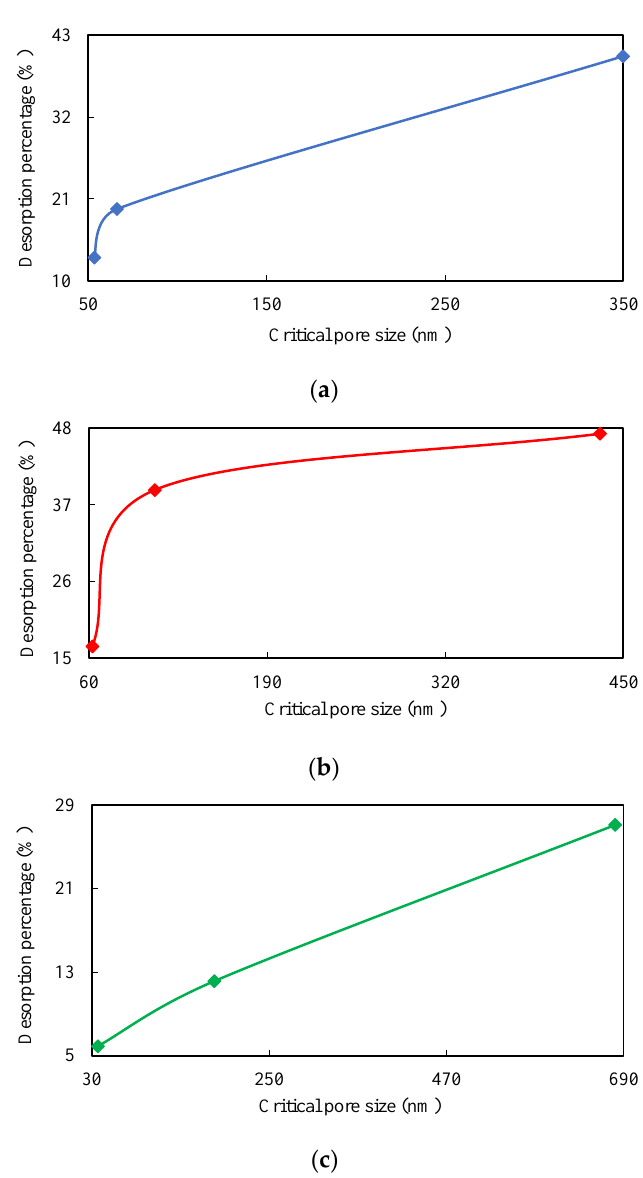
Figure 8. Critical pore size as a function of permanent desorption percentage for the three coal samples considered in this study. ( a ) Coal Sample 1-1; ( b ) Coal Sample 1-2; ( c ) Coal Sample 2-1.